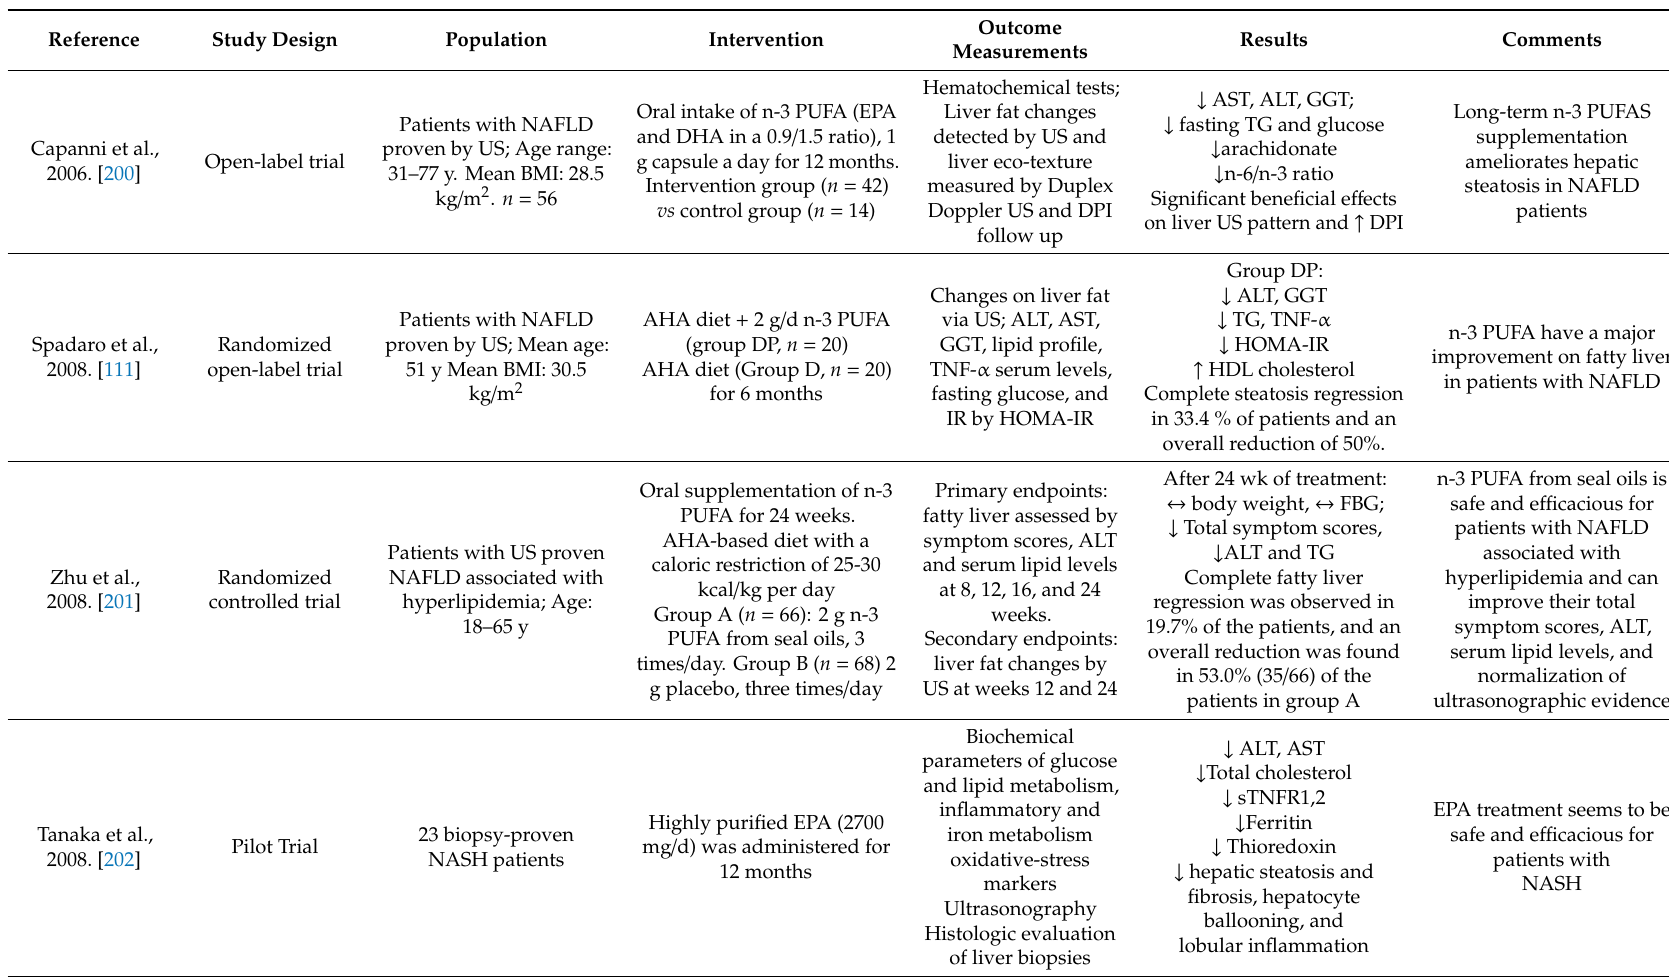
Table 3. E ff ects of n-3 PUFA supplementation in NAFLD (non-alcoholic fatty liver disease) and NASH (non-alcoholic steatohepatitis)